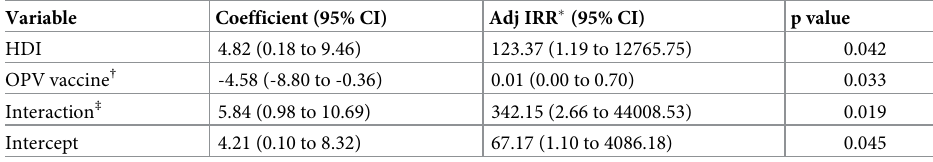
Table 2. Results of negative binomial